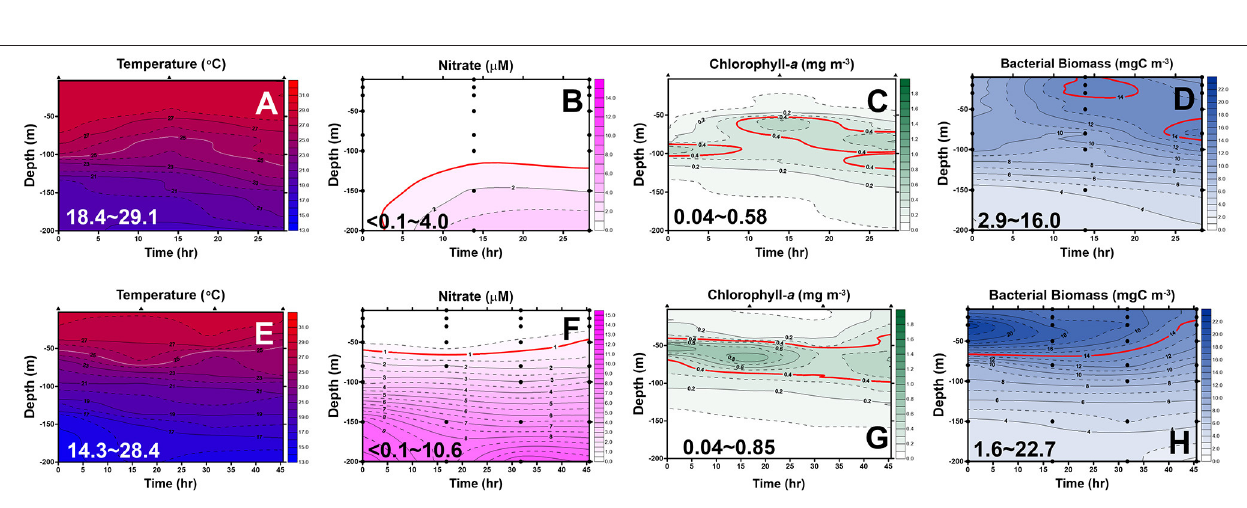
FIGURE 5 | Diel changes of the contour plots of the measurements in the upper 200m of station 6 (A–D) and station 2 (E–H) of the May cruise. The ranges for each measurement are shown in each panel. The lines represent an isotherm of 25 ◦ C (A,E) , isovalue lines of 1.0 µ M nitrate (B,F) , 0.4 mg/m 3 chlorophyll- a (Chl- a ) (C,G) , and 14 mgC/m 3 bacterial biomass (BB) (D,H) ,